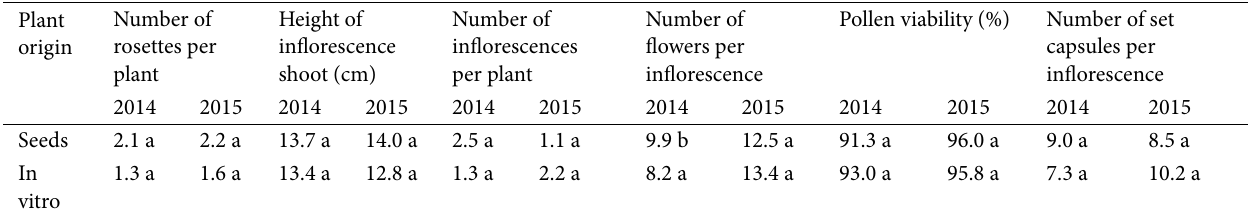
Table 5 Comparison of seed-derived and micropropagated plants of Primula farinosa in 2014 and 2015. Plant